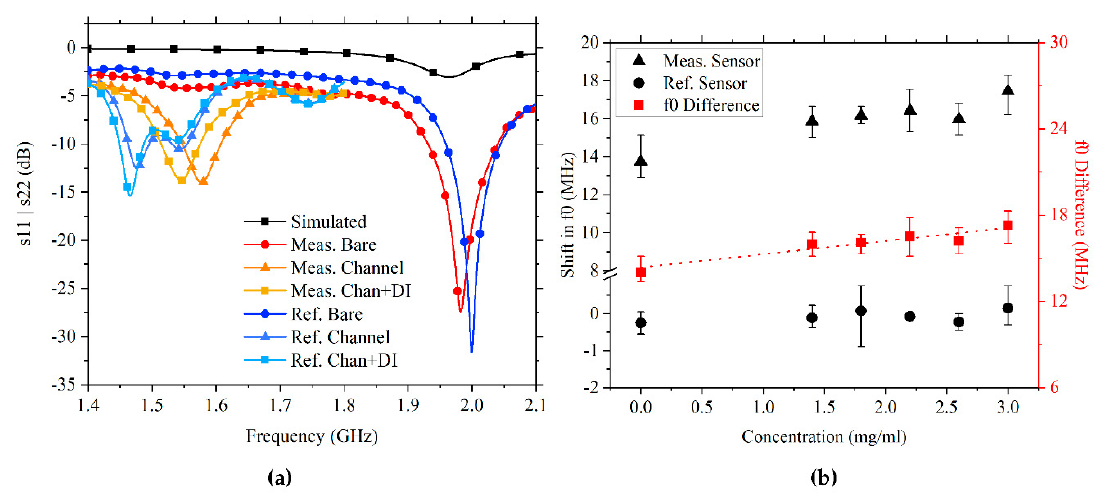
Figure 3. Reflection responses, measured as s 11 and s 22 for bare, empty microchannel added and DI water-loaded microchannel added SRRs ( a ). Shift amounts in f 0 for measuring and reference sensors at different glucose concentration levels and the difference of shifts. Trendline fit (R 2 = 0.9) indicates a sensitivity of 0.92 MHz/(mg/mL) ( b